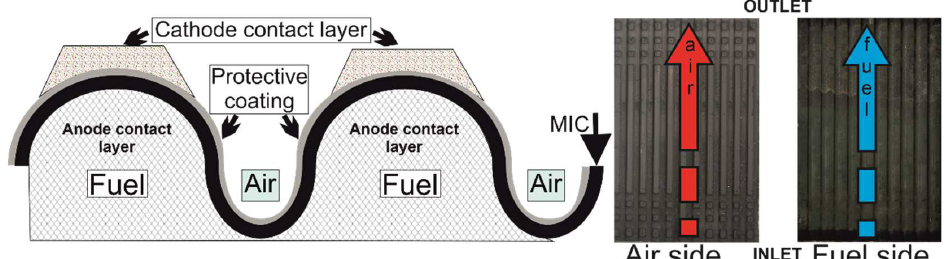
Figure 1. Schematic representation of the MIC cross-section and overall views of the air side ( left ) and the fuel side ( right ) with the inlet–outlet positions indicating the co-flow direction of the streaming.